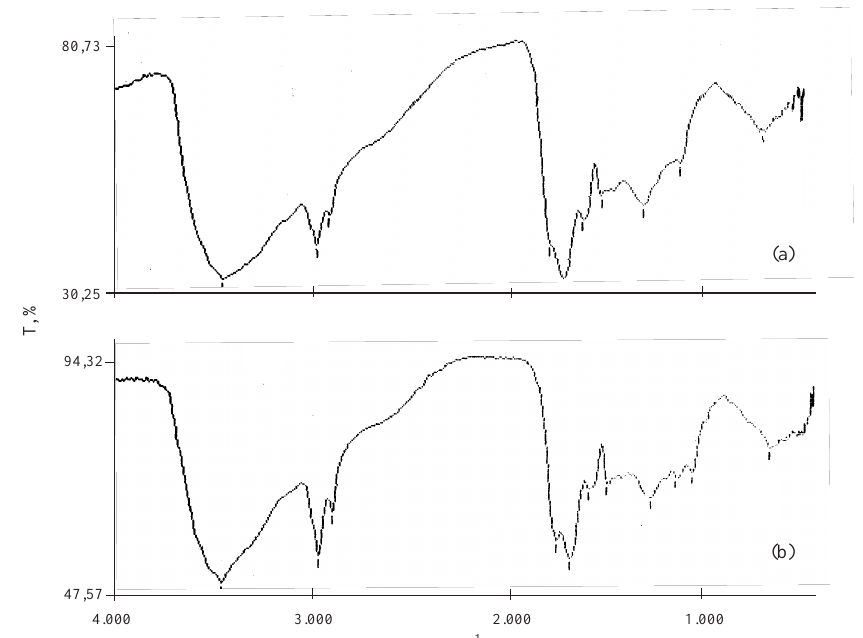
Figura 2. Espectros de infravermelho dos ácidos húmicos extraídos do lodo da estação de tratamento de esgoto (a) e do composto de resíduo domiciliar urbano